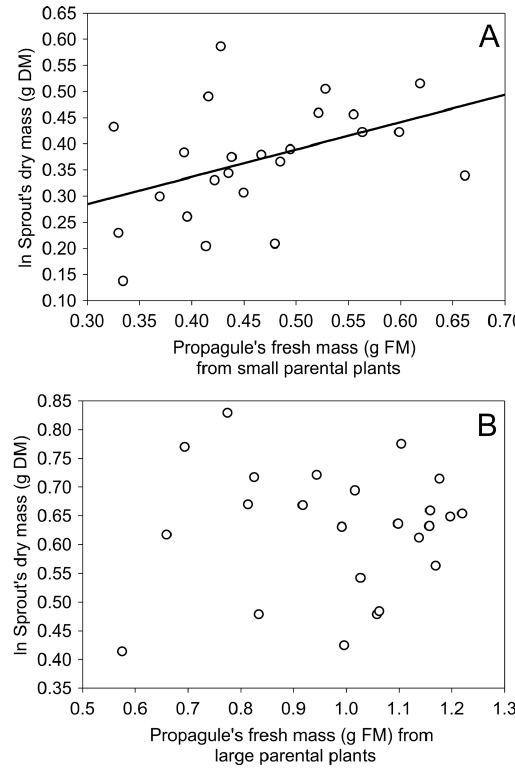
Figure 3. Relationship between U. arrecta’ sprout dry mass (g DM) and propagule fresh mass (g FM) from small (A) and large parental size (B) (N = 24 each).